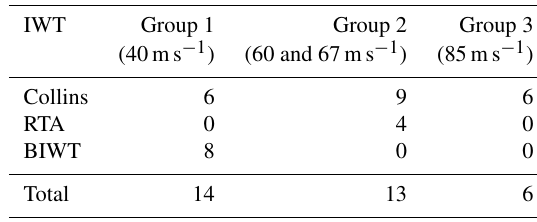
Table 4. Number of small droplet spray measurements per airspeed